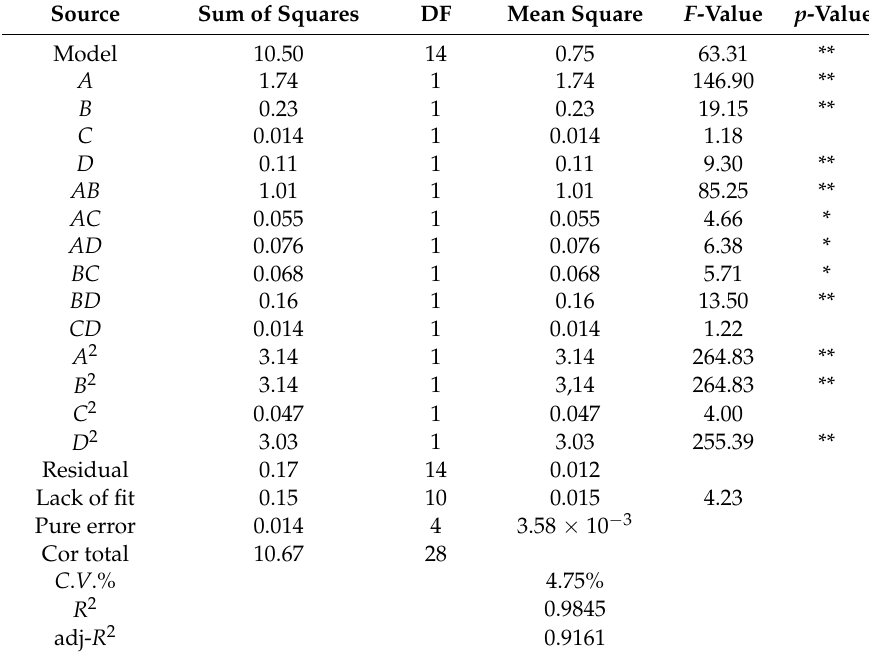
Table 3. Analysis of variance for the second-order polynomial